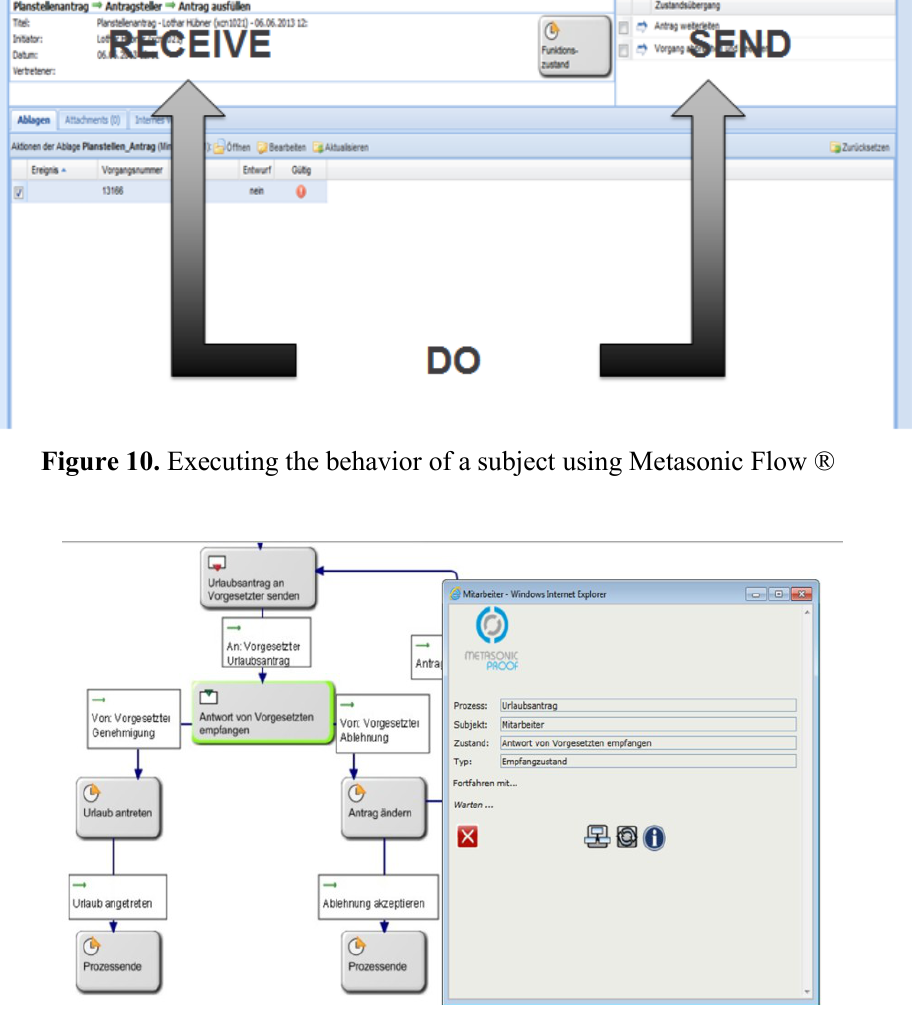
Figure 11 . Correspondence of execution and model representation on the level of Subject Behavior Diagrams using Metasonic Proof ®